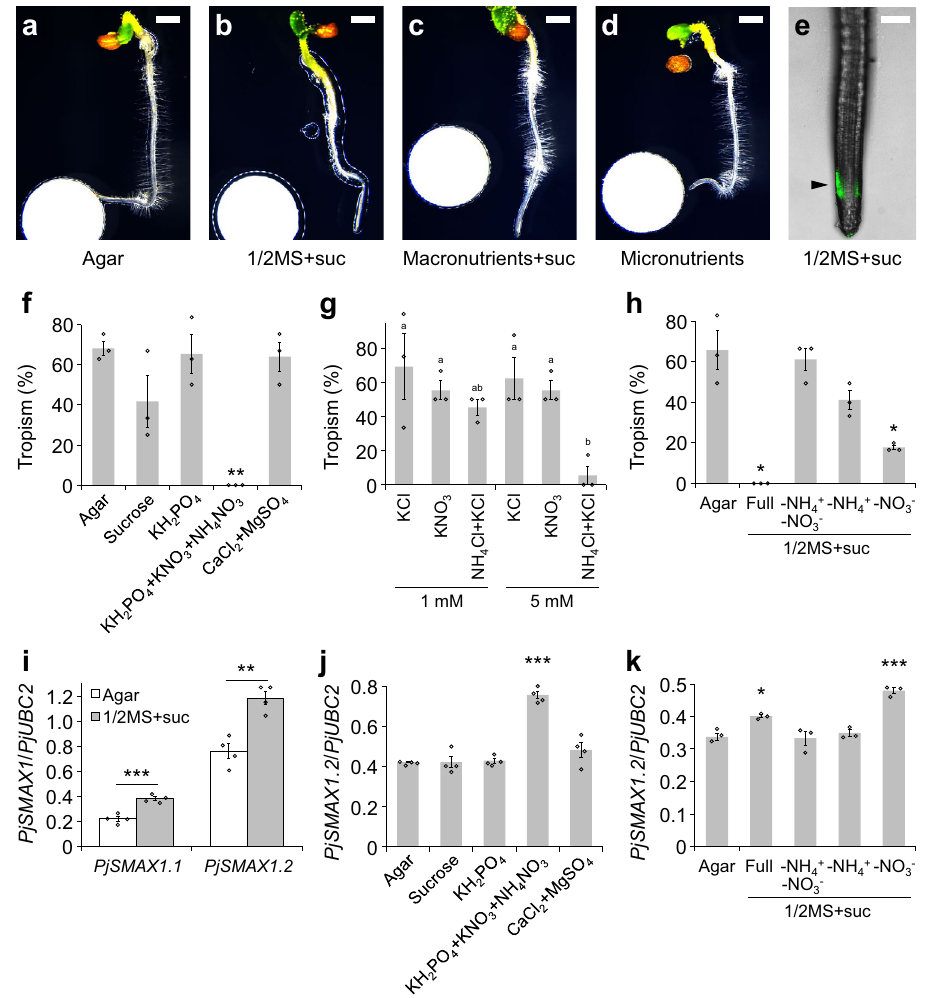
Fig. 2 | Chemotropic phenotype towards SLs on nutrient-containing media. a – d Chemotropic responses to rac -strigol in varying nutrient conditions in the presence of a 1 µ M rac -strigol solution. Photos were taken 1 day after